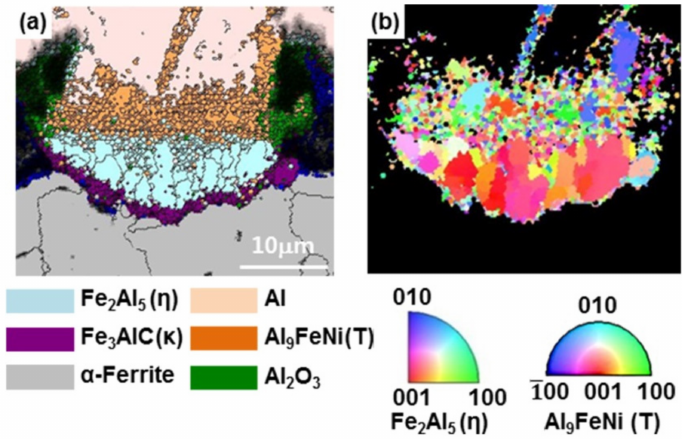
Figure 11. ( a ) EBSD phase map and ( b ) IPF analysis (Al9FeNi (T), Fe2Al5 ( η ) and Fe3AlC ( κ ) phases) of the specimen hot-dipped for 20